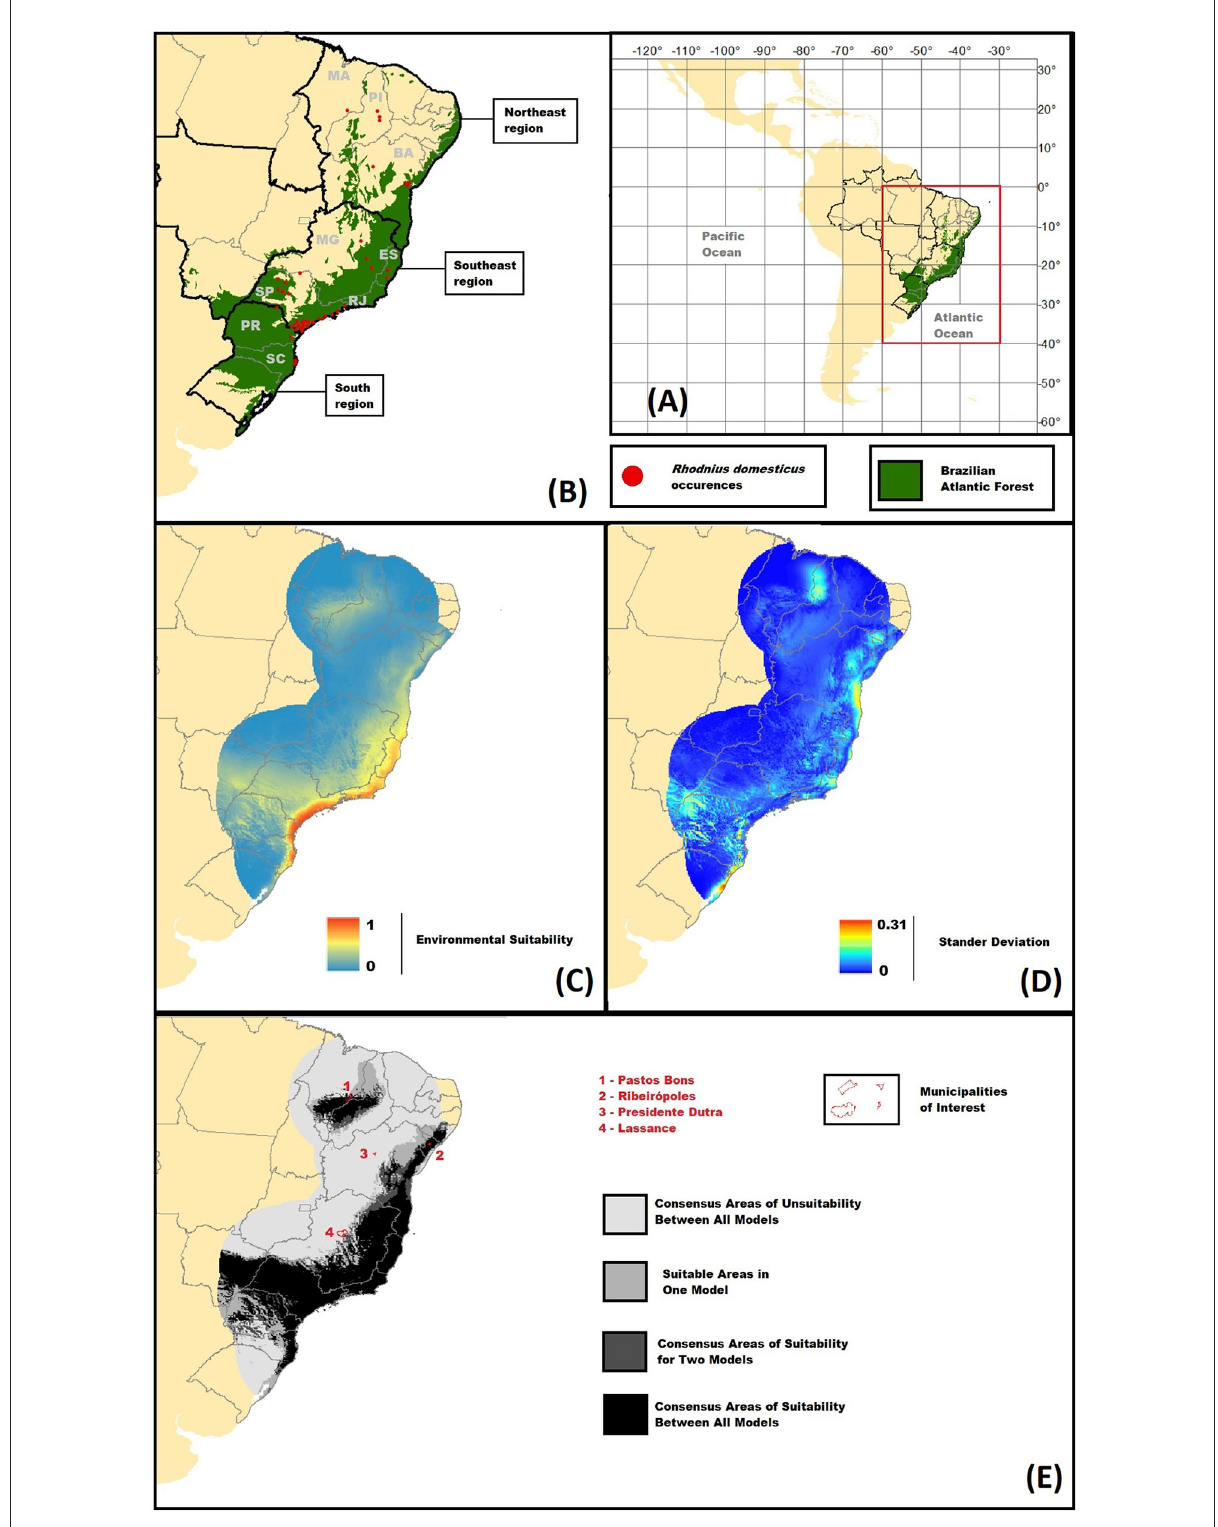
FIGURE1 Spatial data and Ecological Niche models (ENMs) results for Rhodnius domesticus . (A) Study area delimitation project using WGS 1984 datum and coordinate system. (B) Map of R. domesticus known distribution. Red dots represent species records; the green area represents the